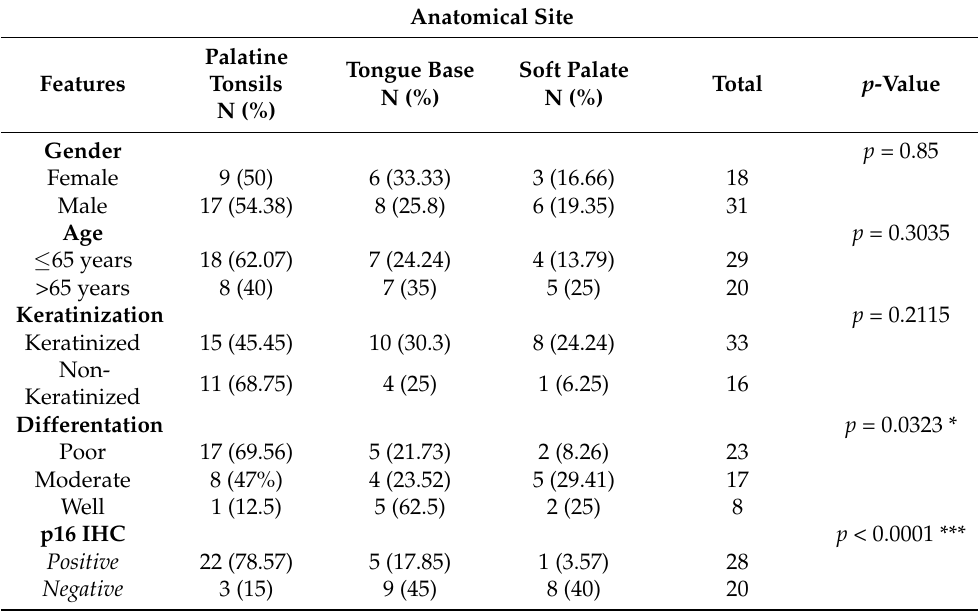
Table 1. Clinicopathological features of